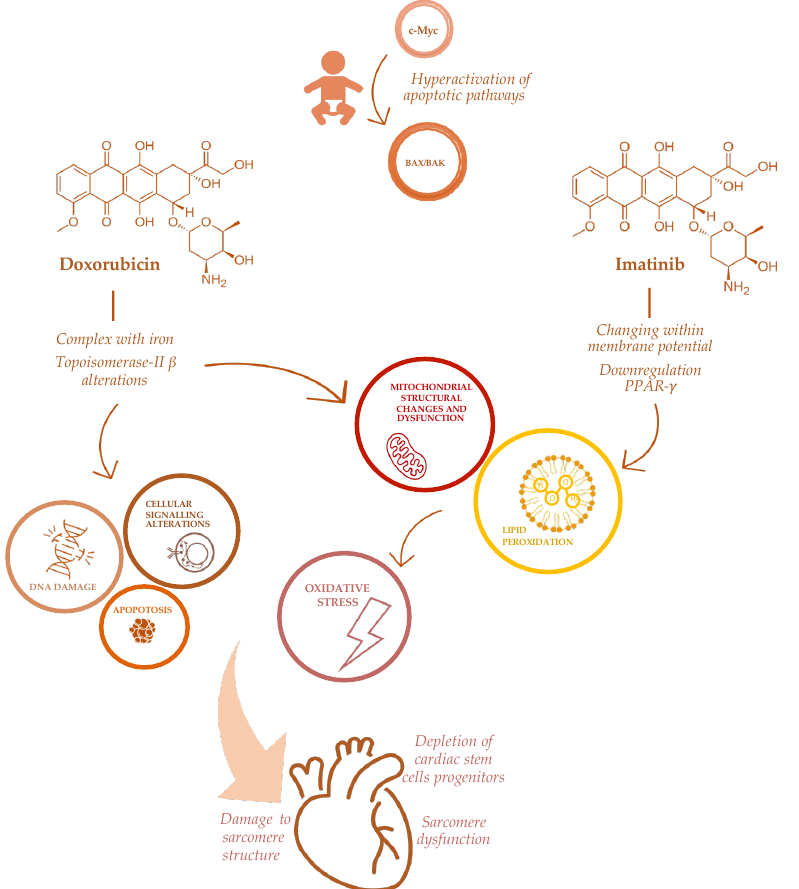
Figure 1. Mechanisms of doxorubicin and imatinib-induced cardiotoxicity in childhood cancer patients. Among chemotherapeutic agents, anthracyclines such as doxorubicin, epirubicin, and daunorubicin remain drugs of choice for many cancer treatments, and cardiotoxicity is a well-known adverse effect of these medications